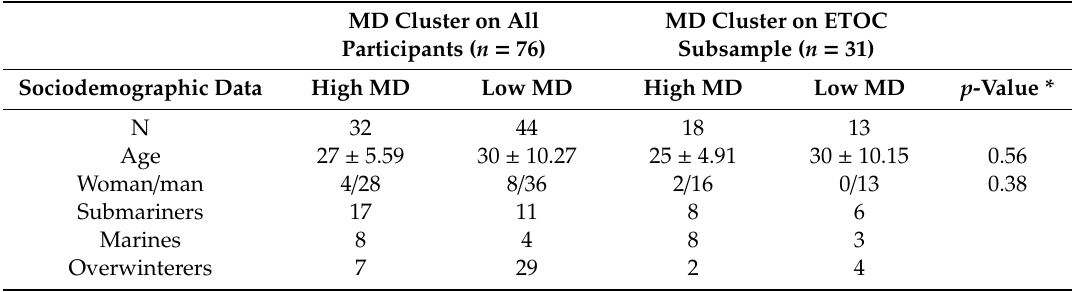
Table 1. Characteristics of participants for each Mindfulness Disposition (MD) cluster (mean ± standard deviation or sample